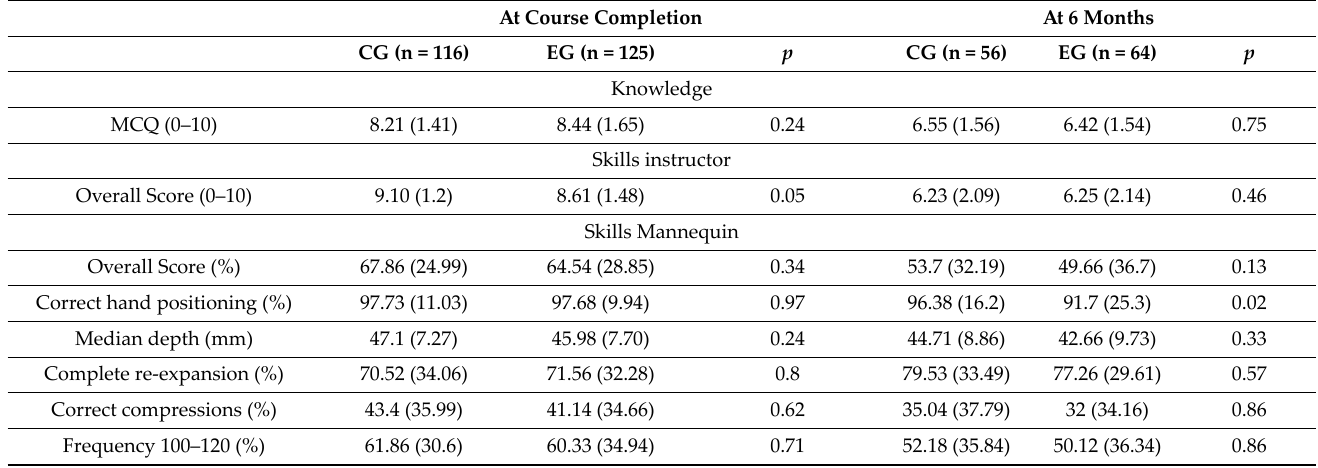
Table 3. Evaluation of knowledge and skills before and after the course and retention at 6